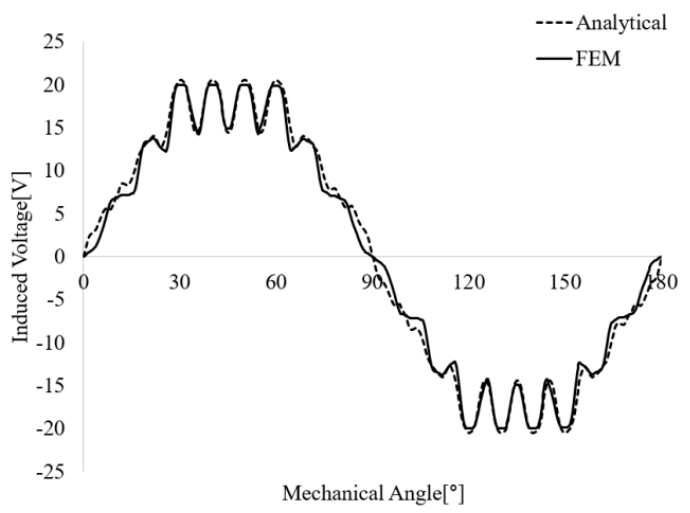
Figure 10. Comparison of the no-load-induced voltage derived from the HMEC and the FEM.